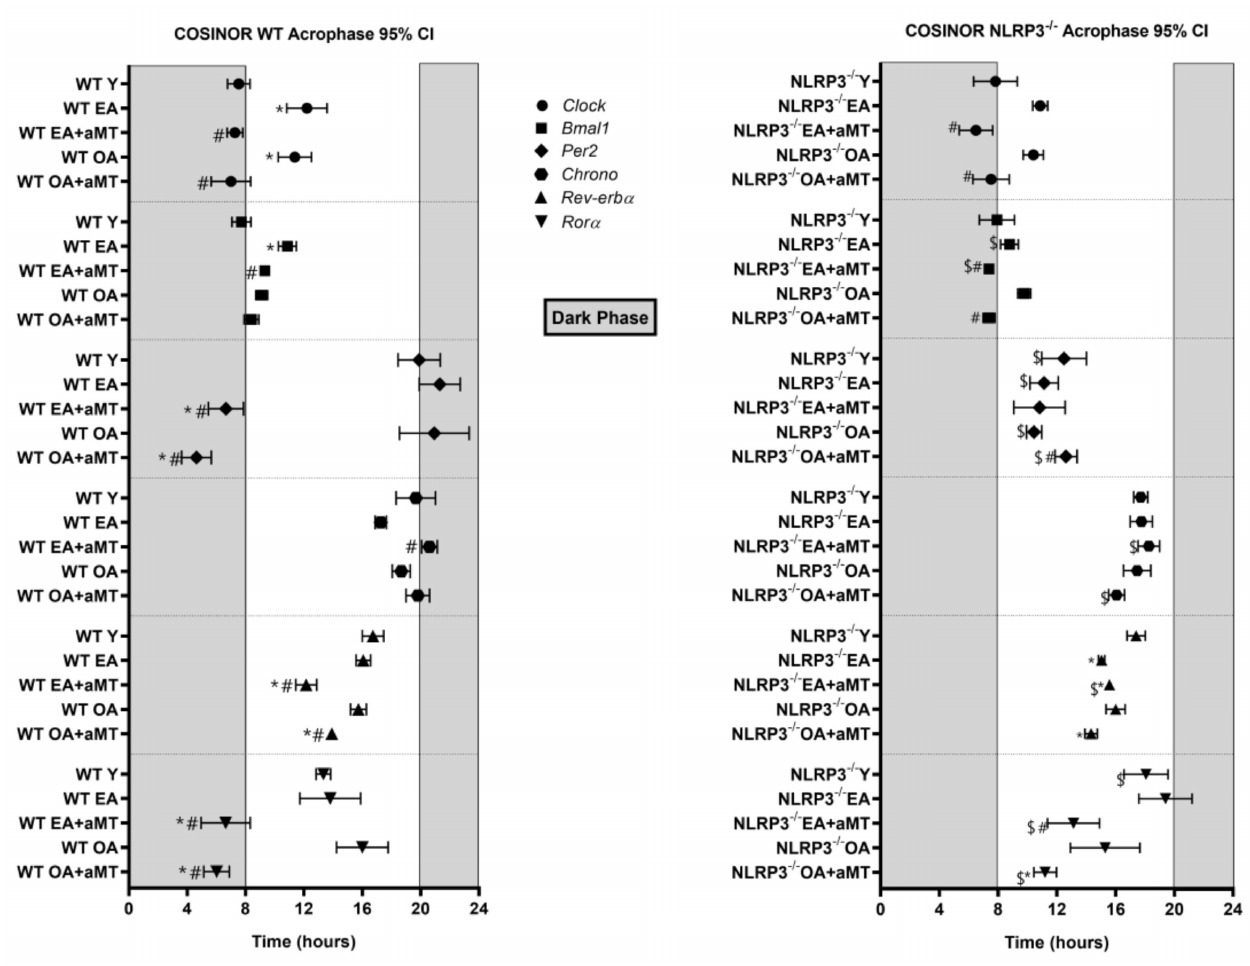
Figure 3. Acrophase charts showing peaks of fitted 24 h cosine for clock genes analyzed in the heart of WT and NLRP3 − / − mice during aging and melatonin treatment. The acrophase of clock genes Clock , Bmal1 , Per2 , Chrono , Rev-erb α , and Ror α in hearts of young (Y), early-aged (EA), early-aged with melatonin (EA + aMT), old-aged (OA), and old-aged with melatonin (OA + aMT) wild type (left chart) and NLRP3 − / − mice (right chart). The shaded region on each graph represents constant darkness. Data are expressed as means ± confidence interval (CI) of the acrophase when p was ≤ 0.05 from the nonzero amplitude. Data of significant differences among the experimental groups were evaluated by overlapping of confidence interval and are detailed in Supplementary Table